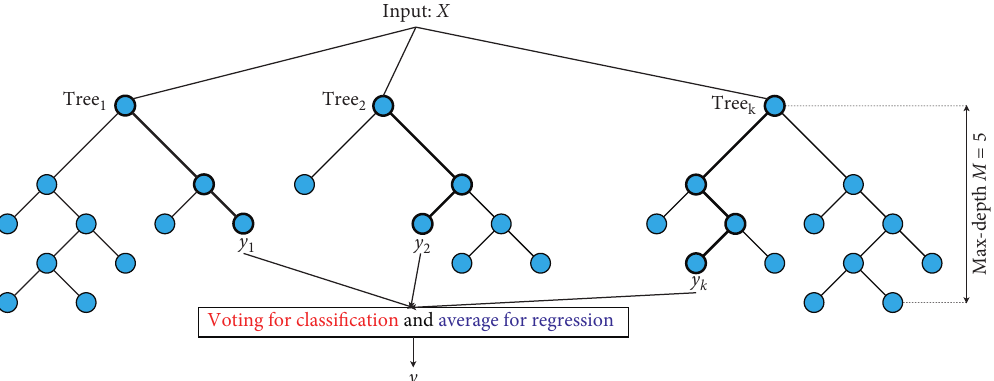
Figure 12: The illustration of tree-based ensemble learning method. The model contains k tree with maximum depth of each tree is M � 5. For each input vector X each tree will predict one target value. The predicted values of all the trees then are combined to the final prediction y .